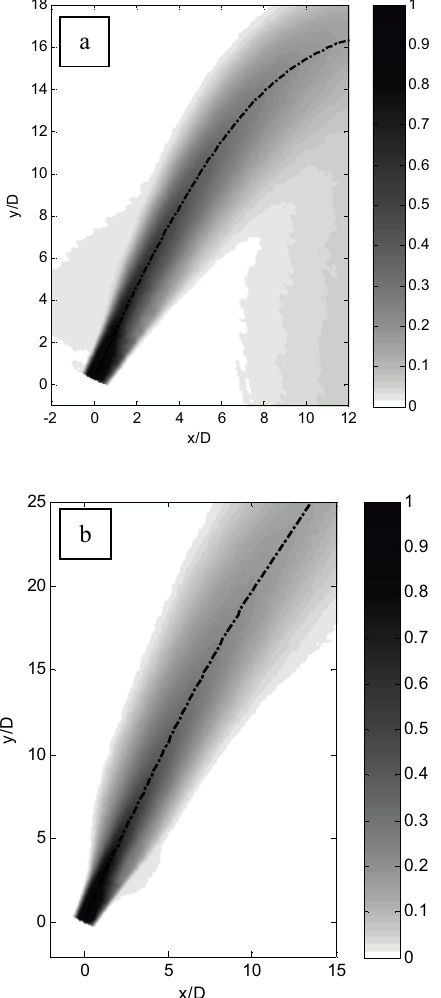
Figure 2. Map of the non-dimensional mean velocity in the near-field of an INBJ with Re = 1000, U/U max θ = 65°, Fr = 8 (a) and 15 (b); the dash-dotted black line is the jet axis.